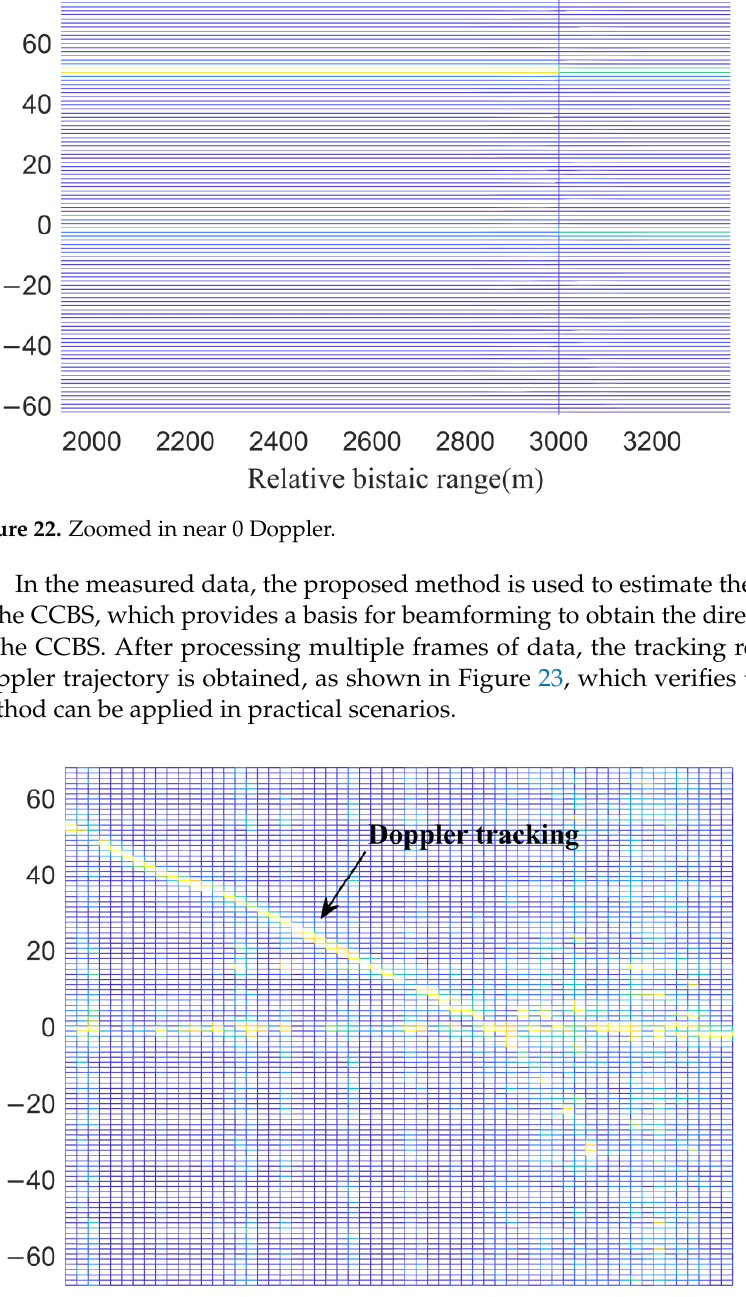
Figure 21. RDCC after eliminating the strong interference in Figure 20.